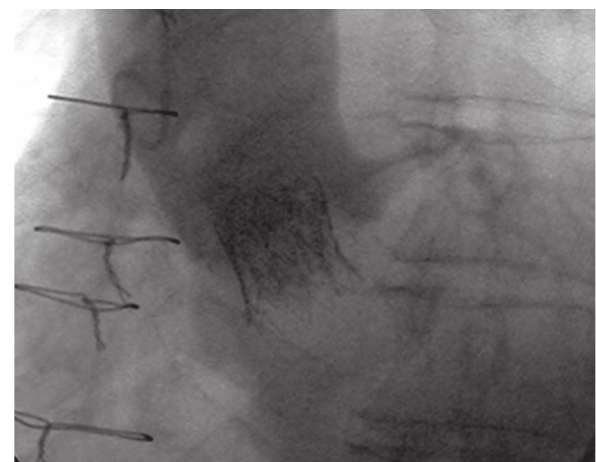
Fig. 1 – Aortografia de controle, demonstrando o